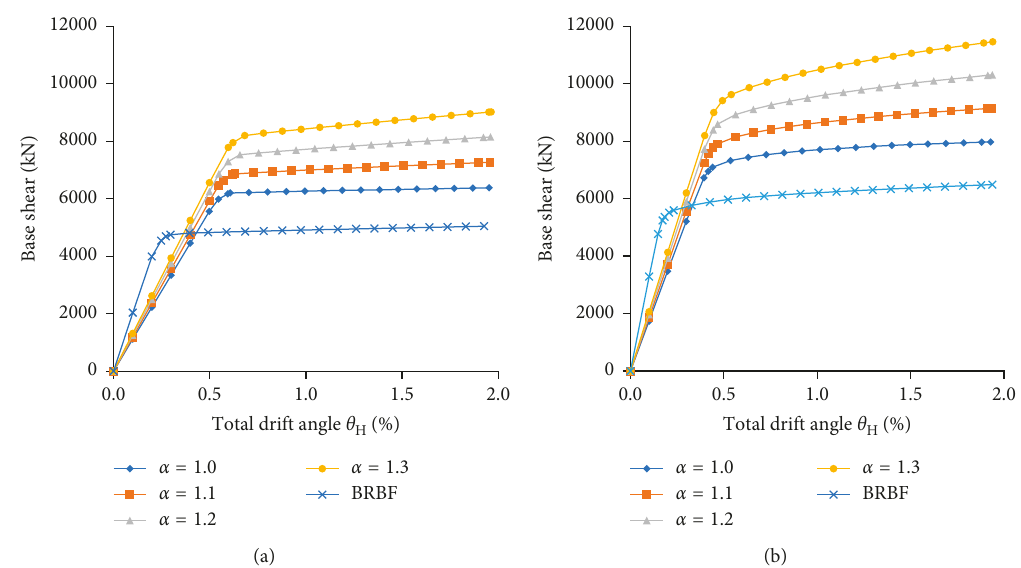
Figure 21: The effects of α on the base shear response of 16-story SC-TOBFs: (a) LD-1 and (b) LD-2.